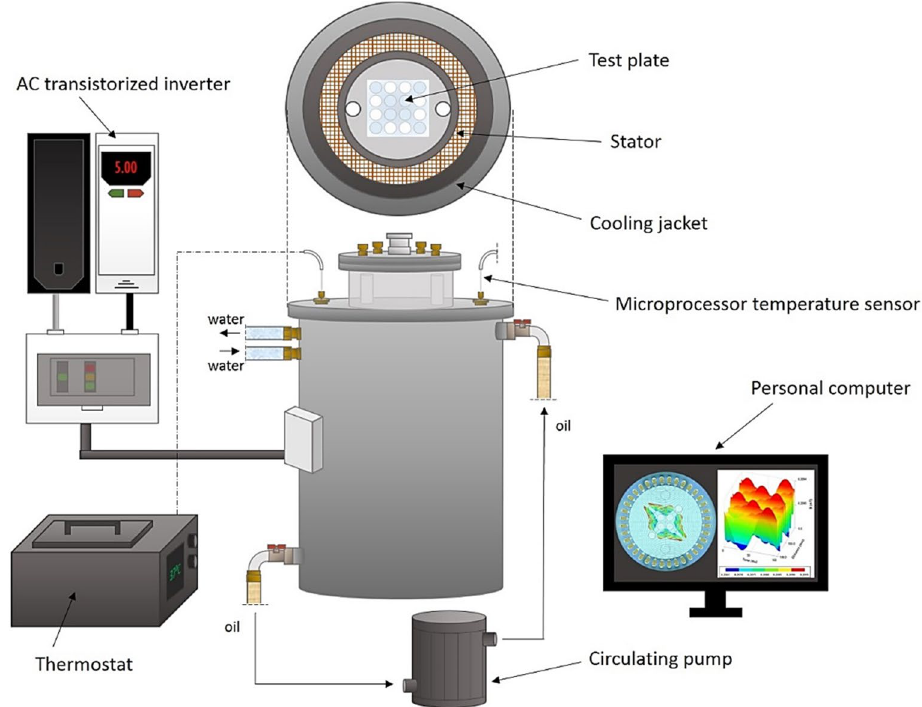
Figure 1. RMF generator with monitoring and control